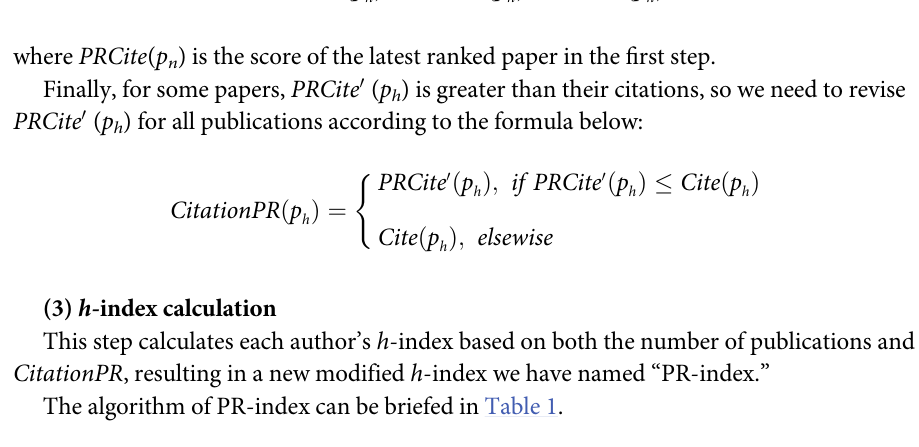
Table 1. The algorithm of